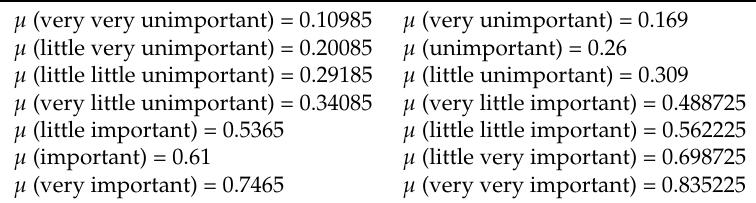
Table 4. Quantitative value of the variable semantic language.